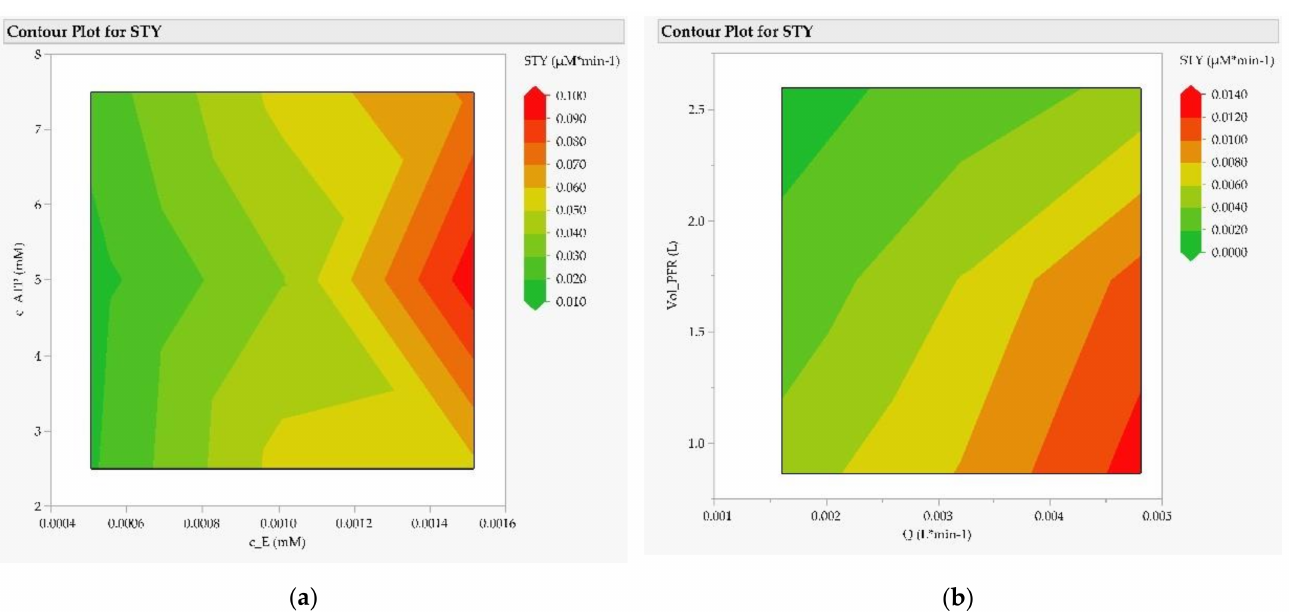
Figure 6. Contour plots as results of the multi-parameter-at-a-time (DoE) sensitivity study with STY (space time yield) as target value when reaching 90% of the maximum mRNA concentration ( a ) Batch reactor, ATP concentration over T7 RNA polymerase concentration; ( b ) Tubular reactor, reactor volume over flow rate from [22].